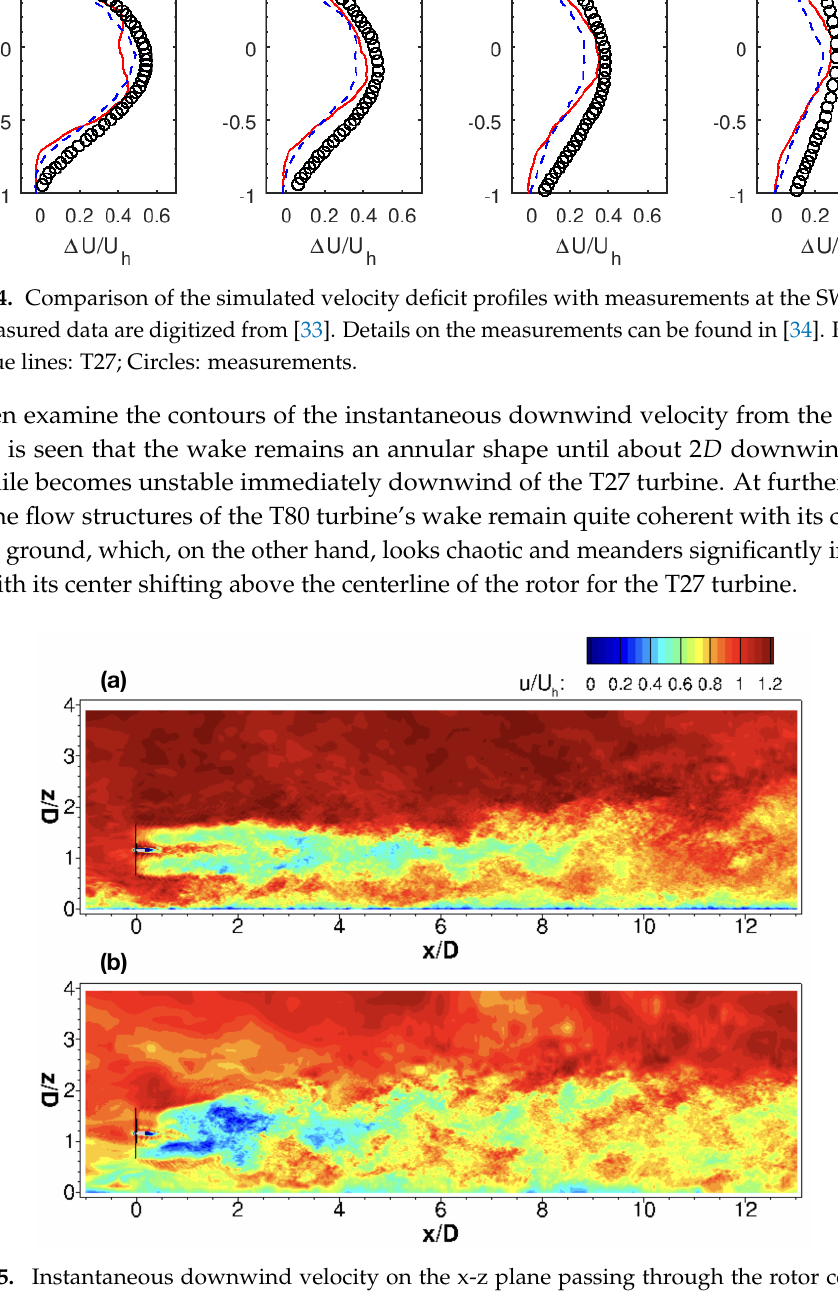
Figure 5. Instantaneous downwind velocity on the x-z plane passing through the rotor center for ( a ) T80 and ( b ) T27,